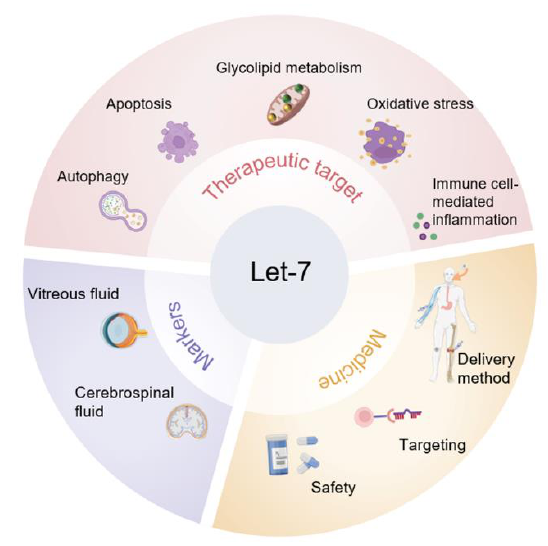
Figure 4. Future research directions of let-7 in aging-related diseases.